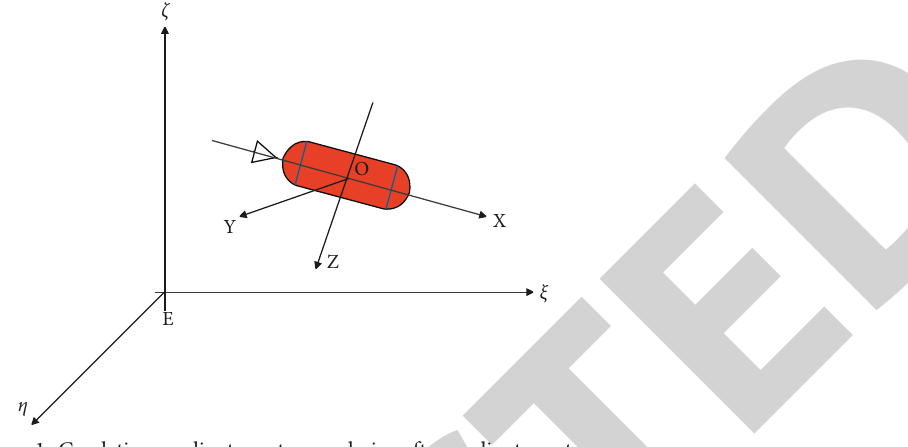
Figure 1: Geodetic coordinate system and aircraft coordinate